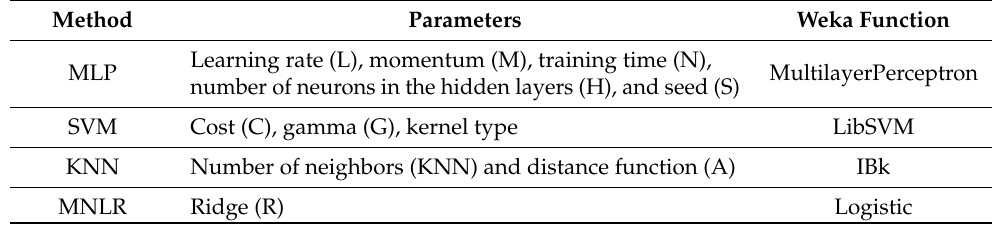
Table 2. Required parameters to operate the classifier in the Weka suite, according to [34]. Method Parameters Weka Function Learning rate (L), momentum (M), training time (N), MLP MultilayerPerceptron number of neurons in the hidden layers (H), and seed (S) SVM Cost (C), gamma (G), kernel type LibSVM KNN Number of neighbors (KNN) and distance function (A) IBk MNLR Ridge (R) Logistic In Weka, the parameter N of MLP refers to the number of epochs to train through and the nodes in the network are all sigmoid. Additionally, the radial basis function (RBF) kernel was used in all experiments using SVM